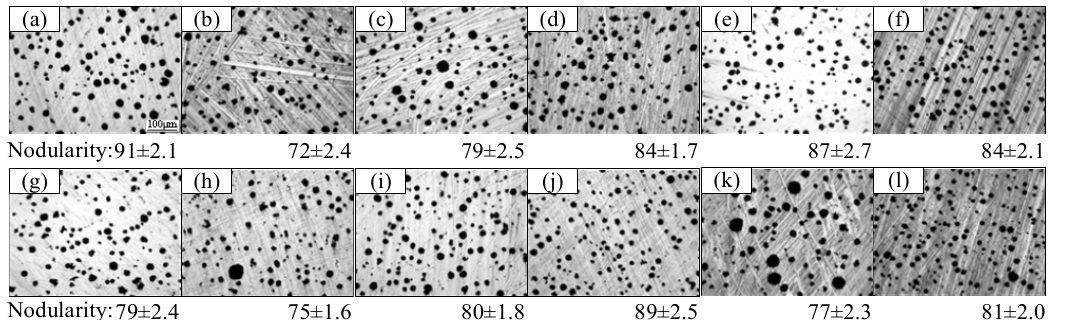
Figure 2. The typical metallographic images and nodularity of specimens (%, Mean ± SD). ( a – j ) W1-1 to W1-10, ( k ) T-1, ( l ) T-2.